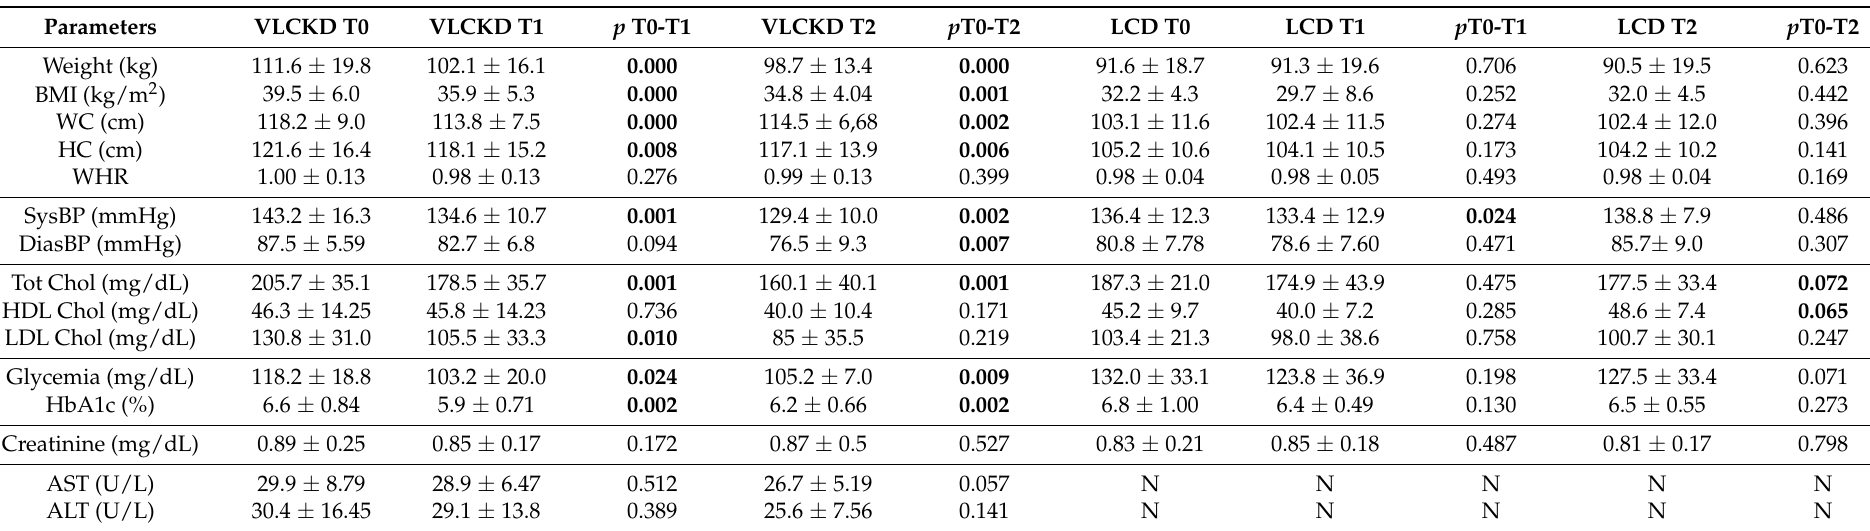
Table 3. Anthropometric and biochemical parameters ( ± SD) at baseline, T1 and T2 in VLCKD and LCD